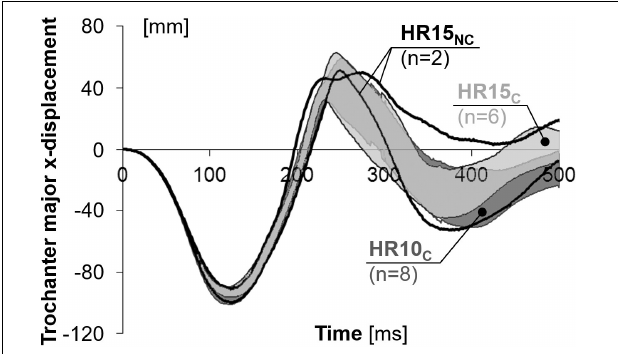
FIGURE 4 | X-displacements of the trochanter major for near 50th percentile female